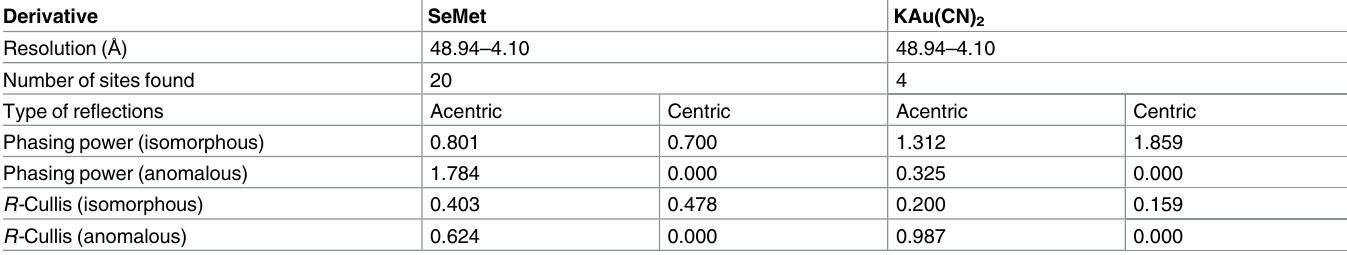
Table 3. MIRAS phasing